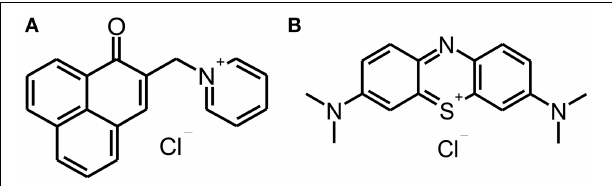
FIGURE 1 | Chemical structures of SAPYR and Methylene Blue. Chemical structures of phenalen-1-one PS SAPYR (A) and phenothiazinium PS Methylene Blue (B)